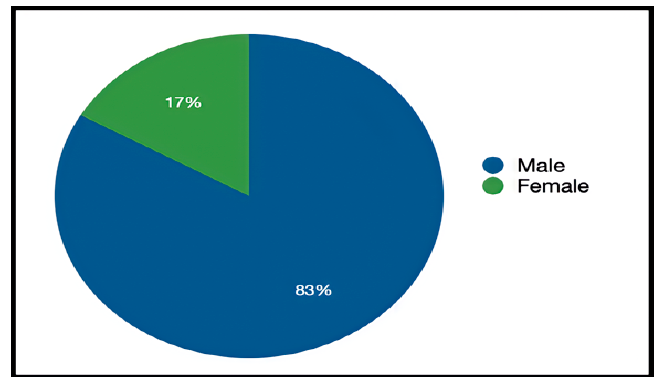
Figure 6. The ratio of males and females in the experiment.